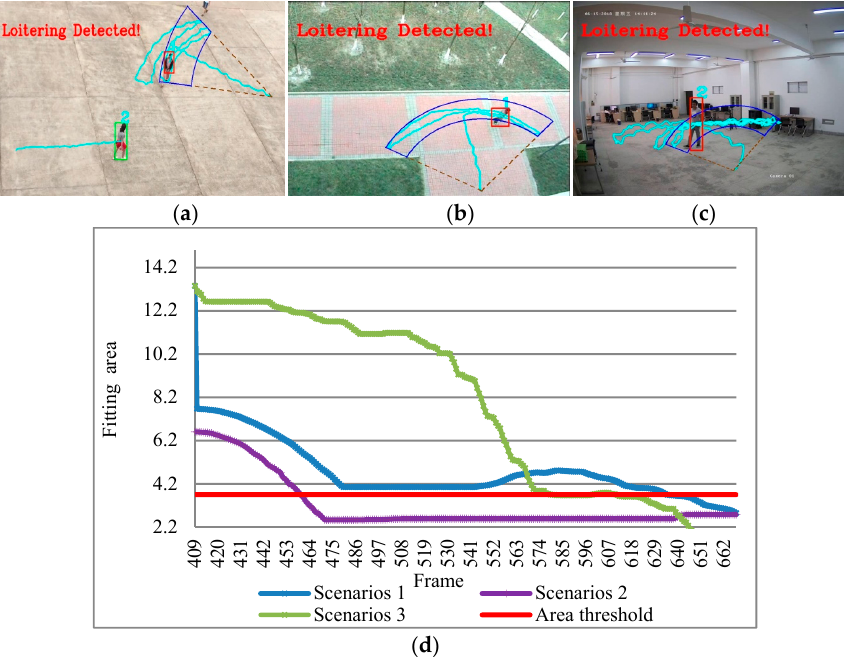
Figure 15. The results of sector loitering. ( a – c ) The sector loitering detection results of video sequence under different scenarios from scenarios 1 to 3. ( d ) The area fitting curve results of sector loitering, the red line in the figure indicates the threshold of the area.